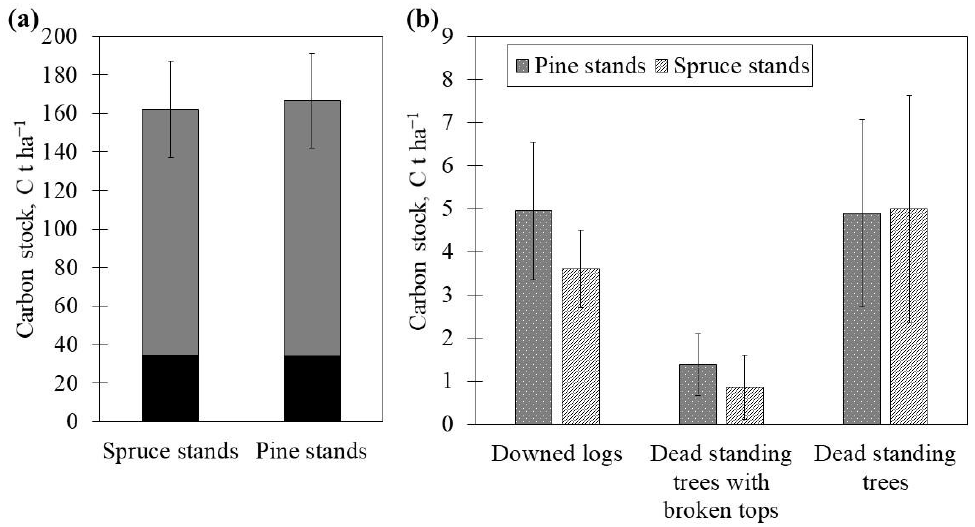
Figure 2. The mean ( ± 95% confidence interval) carbon stock of live tree biomass: ( a ) above-ground biomass carbon stock (grey stacked bars) and below-ground biomass carbon stock (black stacked bars) in old-growth pine- and spruce-dominated stands; and ( b ) deadwood carbon stock by deadwood types in old-growth pine-dominated (dark grey dotted) and spruce-dominated (light grey diagonal stripes) old-growth stands.